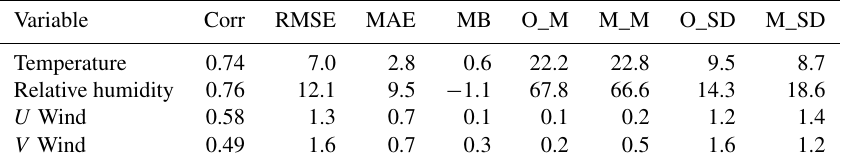
Table 4. Statistics for surface temperature, relative humidity, and wind. Corr – correlation; RMSE – root mean square error; MAE – mean absolute error; MB – mean bias; O – observation; M – model; O_M – observed mean; M_M – model mean; SD – standard deviation. Units for RMSE, MAE, MB/O_M, M_M, O_SD, and M_SD: degrees Celsius for temperature, percentage for relative humidity, and meters per second for wind. Variable Corr RMSE MAE MB O_M